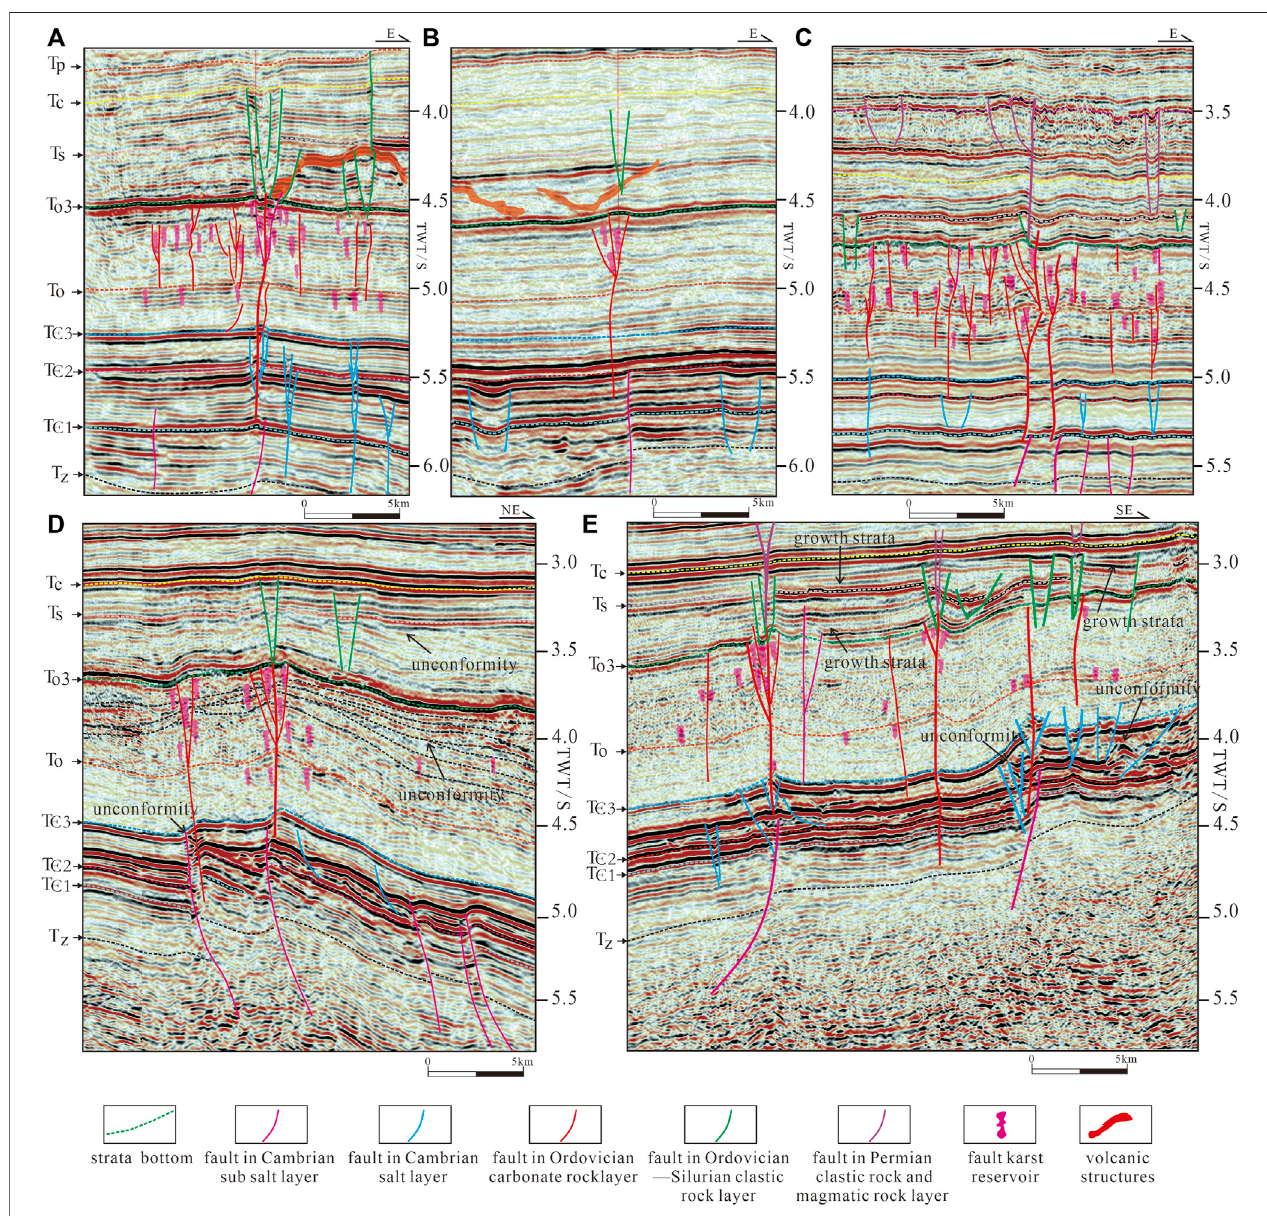
FIGURE 13 | 3D seismic pro fi les of the central Tarim Basin (for location, see Figure 5 ): (A) Opposite superposition of strike-slip fault from the Cambrian to the OrdovicianintheManxilowuplift, (B) earliersagintheCambrianlayerintheManxilowuplift, (C) largerfaultintheCambrianlayerintheTabeiuplift, (D) strongdeformation in the Cambrian salt layer and unconformity in the Ordovician layer in the Tazhong uplift, and (E) opposite superpositions and strong deformation in the Cambrian salt layer in the Tazhong uplift. Please refer to the supplementary materials for the uninterpreted seismic data.